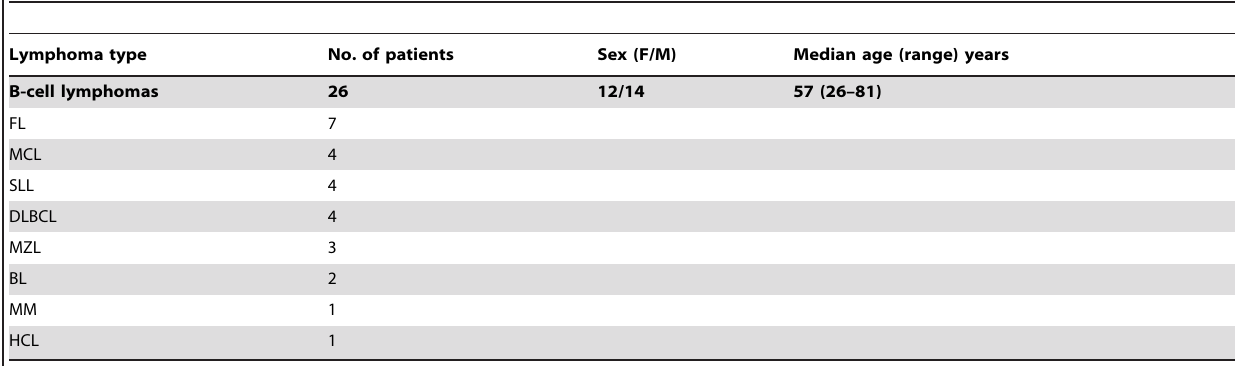
Table 1. Patient characteristics.